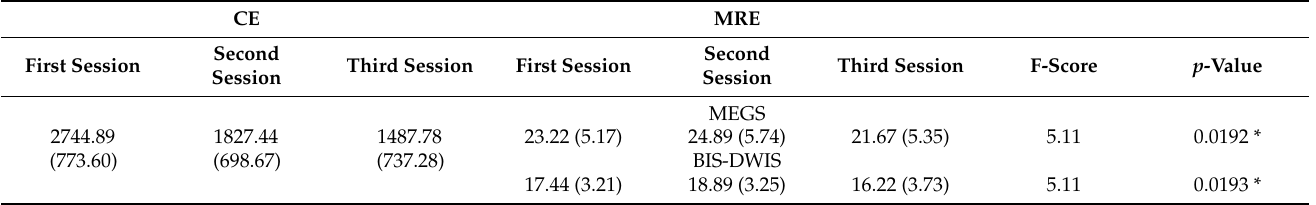
Table 5. Time-dependent differences according to the sessions between Lewis score for CE and two MRE scores of MEGS and BIS-DWIS on 9